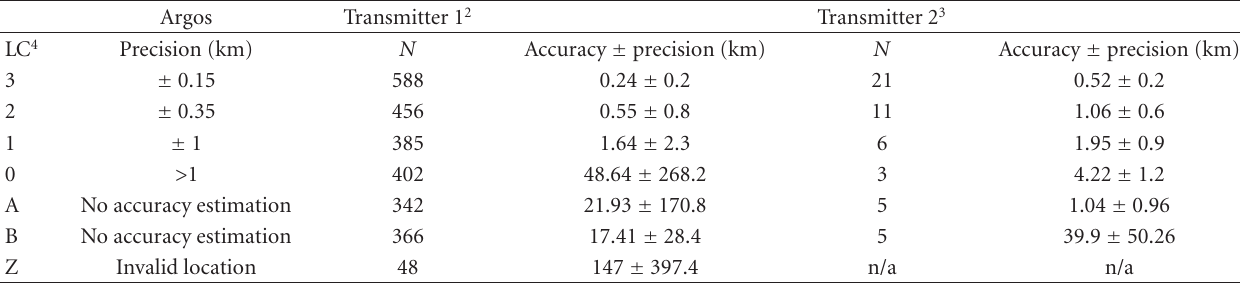
Table 4: Accuracy and precision 1 (km) by Location Class (LC) from two stationary